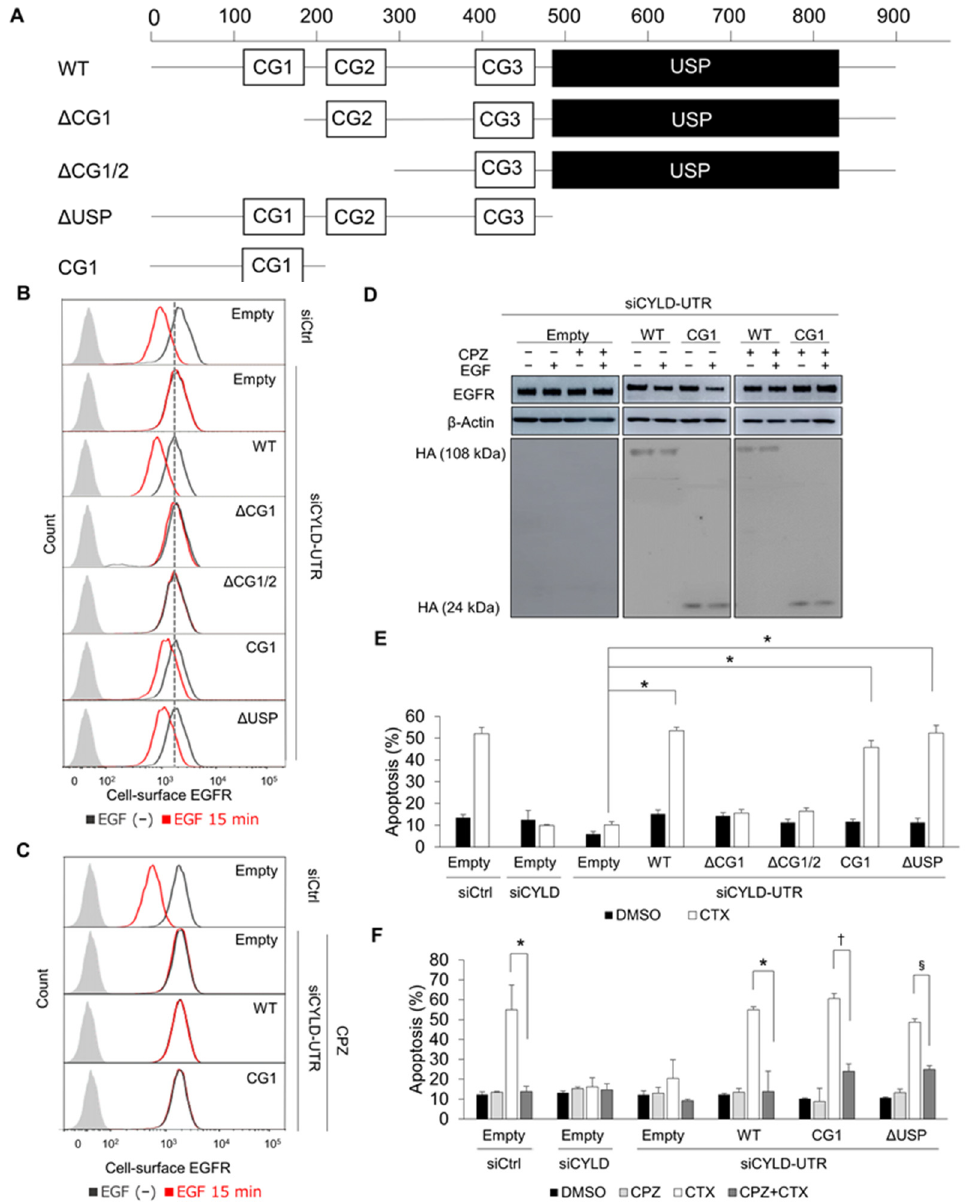
Figure 3. Impact of CYLD domain deficiency on CTX’s efficacy. ( A ) Domain structure of human CYLD protein and constructs encoding deletion mutants of CYLD. Three CG domains (CG1–3) and the USP domain are shown as white and black boxes, respectively. ( B ) The effects of CYLD mutants on cell-surface EGFR expression after EGF stimulation. HSC3 cells were co-transfected with CYLD deletion mutants and siRNA. After a 48 h incubation, cells were stimulated with 100 ng/mL of EGF for 15 min. Flow cytometry was used to analyse cell-surface EGFR expression. ( C ) The effects of WT-CYLD and CG1 constructs on cell-surface EGFR expression after EGF stimulation in combination with CPZ. HSC3 cells were co-transfected with WT-CYLD or CYLD mutants and siRNA. After a 48 h incubation, cells were stimulated with 100 ng/mL of EGF for 15 min. CPZ (5 µM) was added 30 min before adding the EGF. Flow cytometry was used to analyse cell-surface EGFR expression. ( D ) The effects of CYLD mutants on total EGFR expression. HSC3 cells were co-transfected with WT-CYLD or CG1 constructs and siRNA. After incubation for 48 h, the medium was changed to a serum-free medium and then the incubation continued for 12 h. Cells were stimulated with 100 ng/mL of EGF or 100 µg/mL of CTX for 60 min and were analysed by immunoblotting. ( E , F ) The effects of CYLD mutants on apoptosis induced by CTX. HSC3 cells were co-transfected with WT-CYLD or CYLD deletion constructs and siRNA. After incubation for 12 h with 100 µg/mL of CTX in serum-